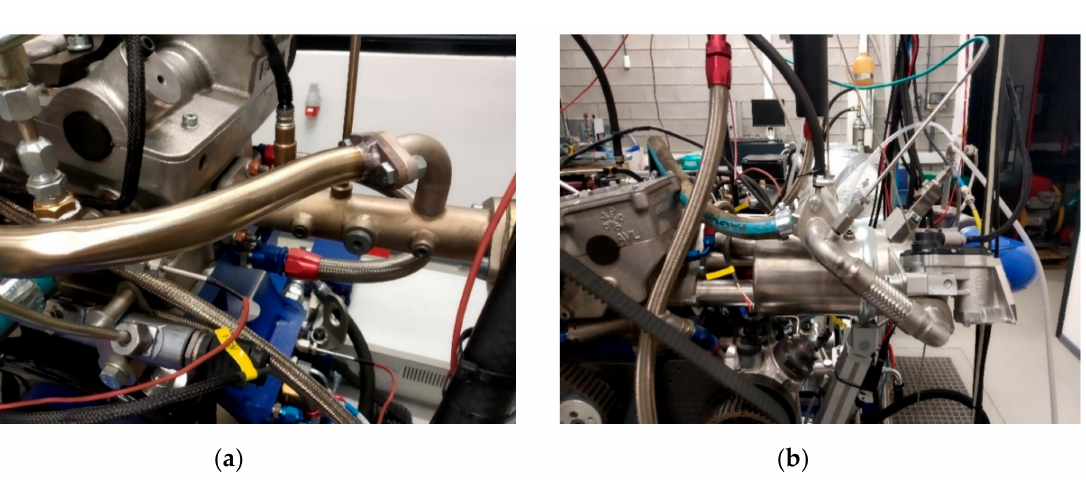
Figure A3. The intake and exhaust engine runners; ( a ) exhaust runner with UEGO sensor, exhaust pressure sensor, and EGR runner system; ( b ) EGR mixing chamber with sensors and temperature conditioning system (on the